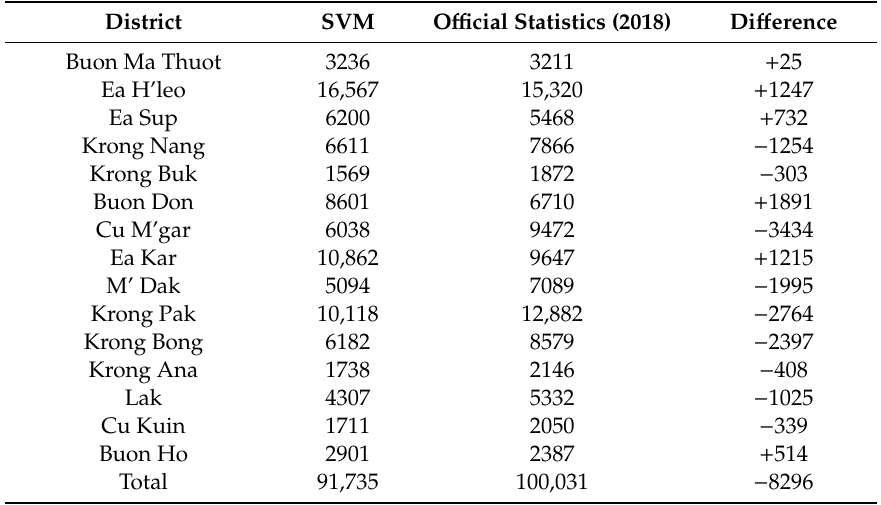
Table 2. Comparison of total cultivated maize acreage by districts from Support Vector Machine (SVM) classifier estimation and the 2018 o ffi cial statistics (expressed in